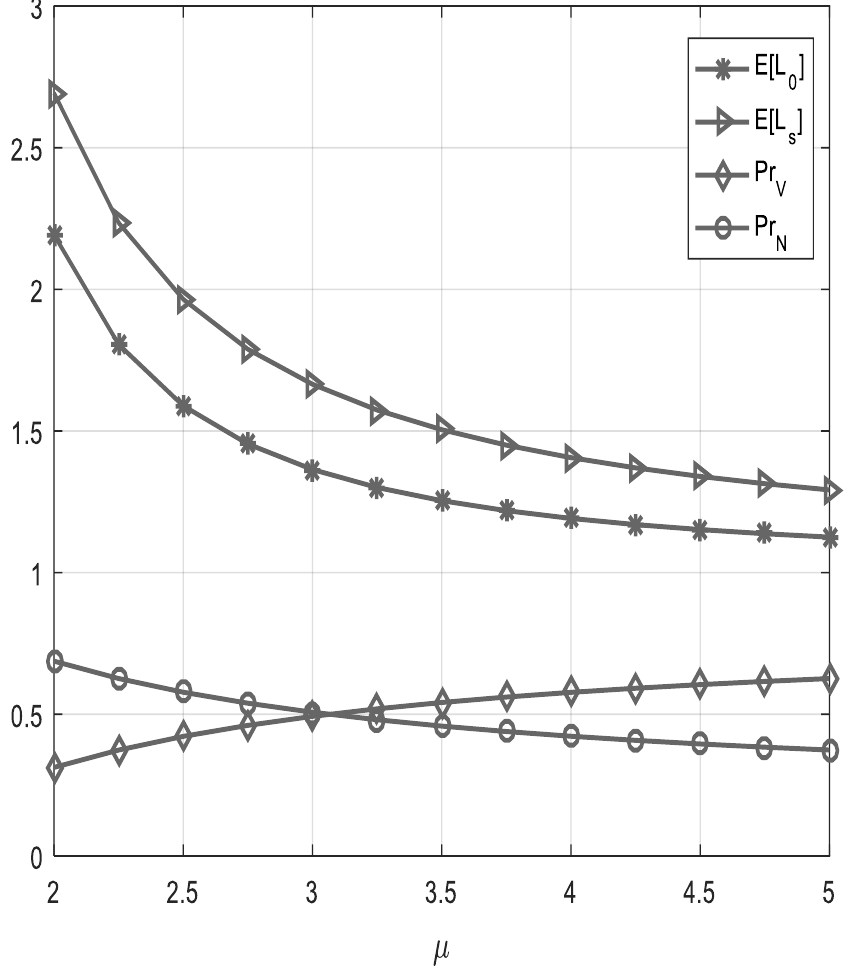
Figure 2. Effect of service rate (μ) on system performance